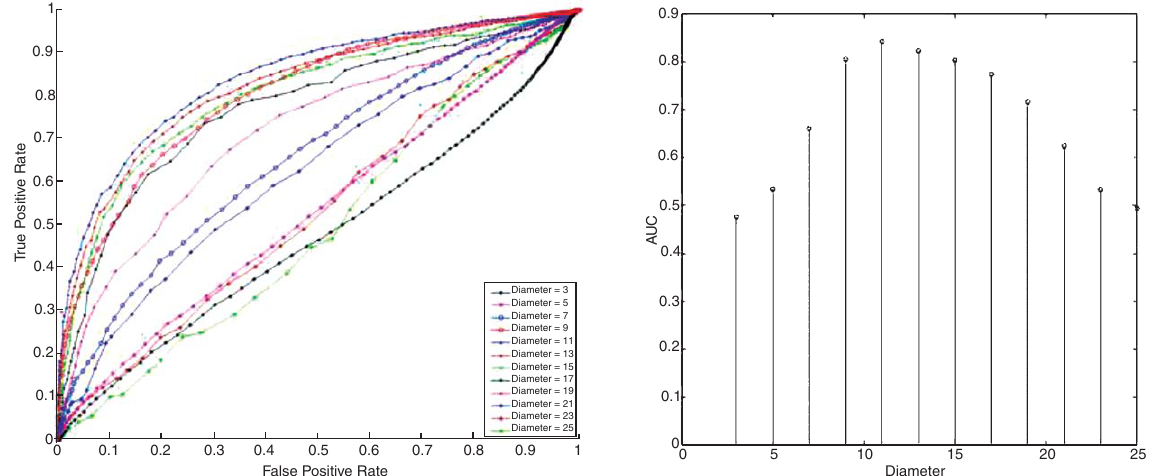
Fig. 4. Effect of the ring size. A similar point within the nest of cancer cells was selected to generate rings ranging in size from 3–25 pixels in diameter (with the maximal number of sub-rings, sampling every other ring). The panel to the right shows an incremental improvement in the ROC curves as the size of the ring was increased from 3–11 pixels in diameter, followed by an incremental degradation in the ROCs from 11–25. The panel to the left demonstrates the corresponding AUCs with vector size of 11 demonstrating the greatest AUC, 0.84.